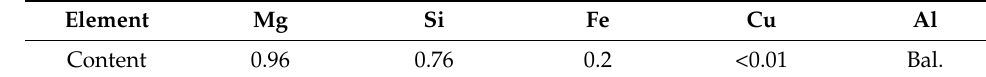
Table 1. Chemical composition of A508-3 steel in wt%.